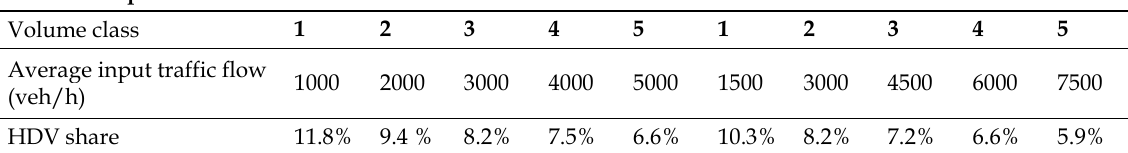
Table 2. Traffic volume classes and HDV share in traffic simulations Nr of lanes per direction